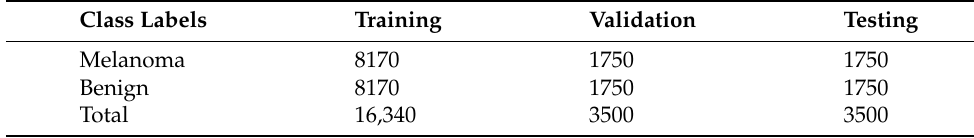
Table 2. Summary of the ISIC-2020